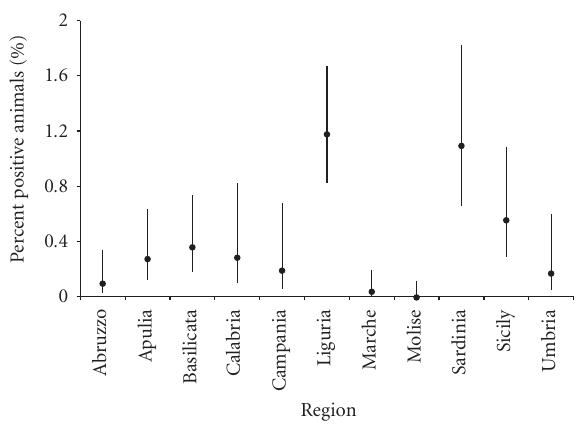
Figure 5: Percent of sera coming from the National Serum Bank (NSB, collected during the 2001–2003 period) and resulted positive to RB51-CFT, on regional basis.